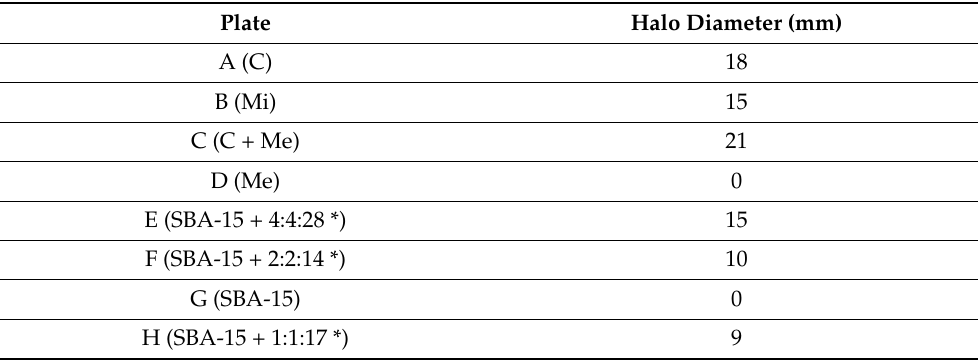
Table 4. Bacterial Inhibition Halos (mm). * (Ci:Me:Mi). SBA-15 (Santaba Barbara Amorphous 15, Ordered mesoporous silica,